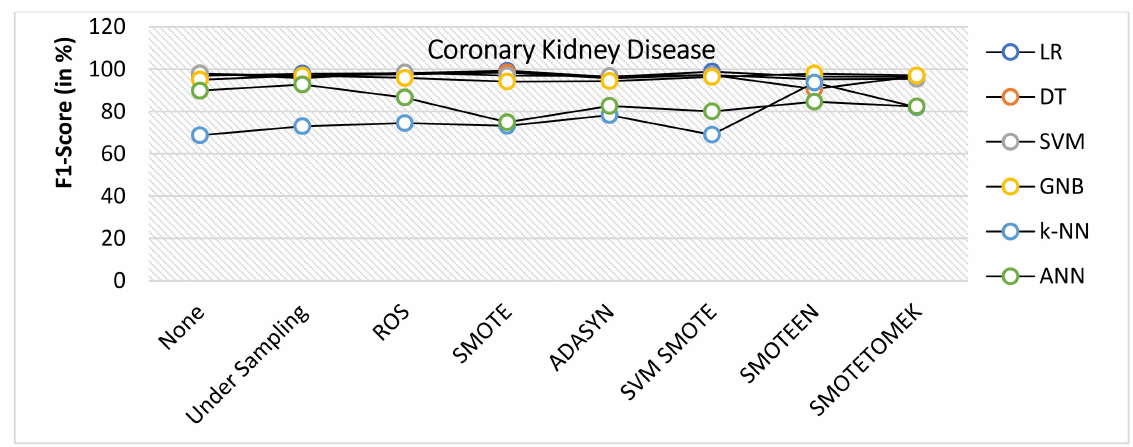
Figure 17. F1 score for kidney disease dataset of balancing algorithms over six